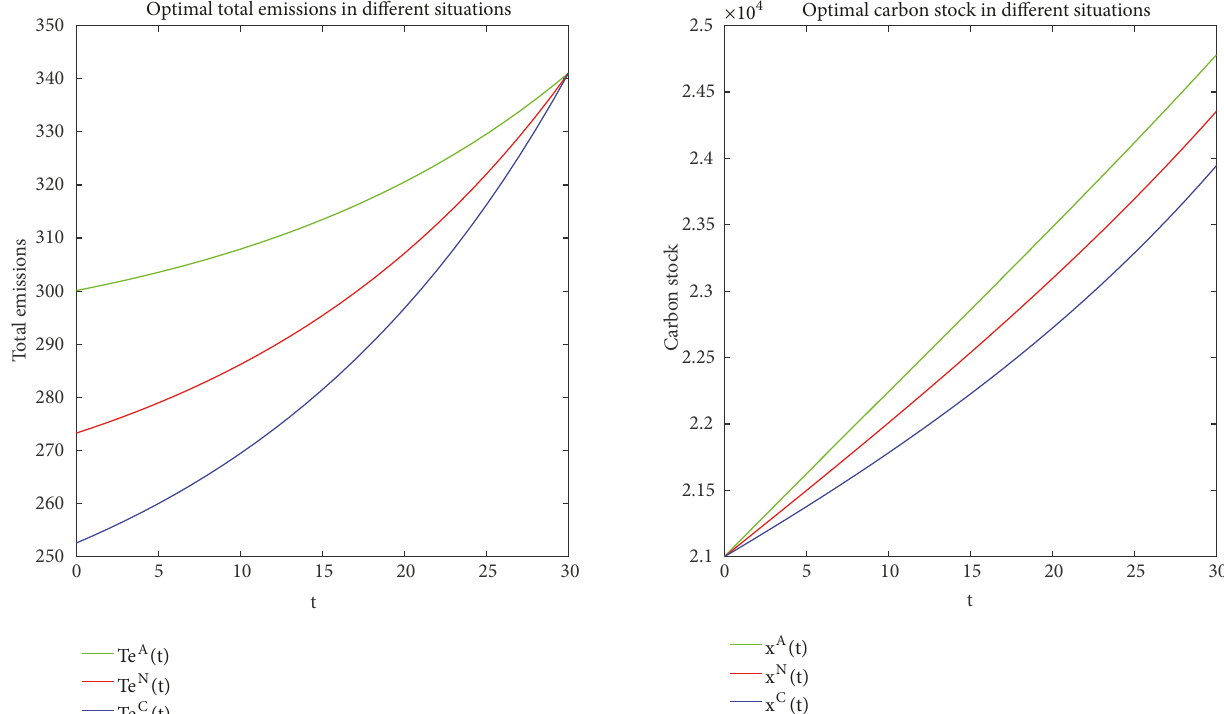
Figure 2: The optimal total net emissions and carbon stocks in the case